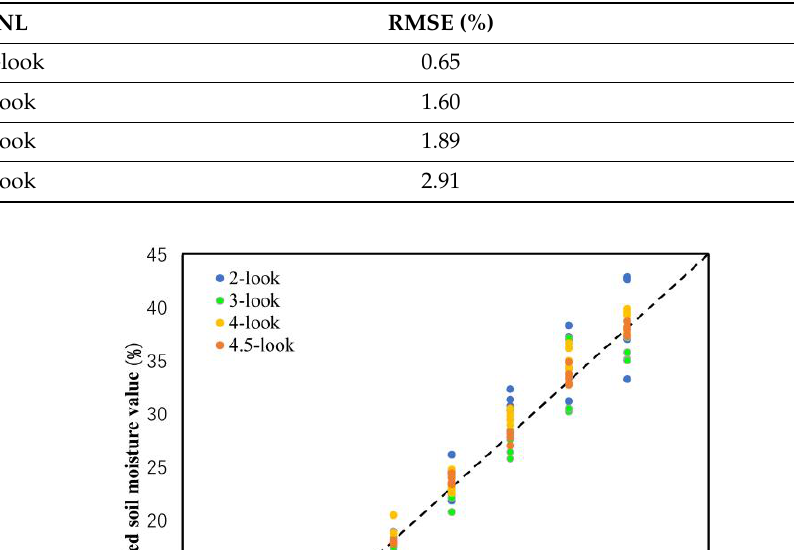
Table 6. Simulated data RMSE and r 2 of the dual-channel CNN in different levels of noise.